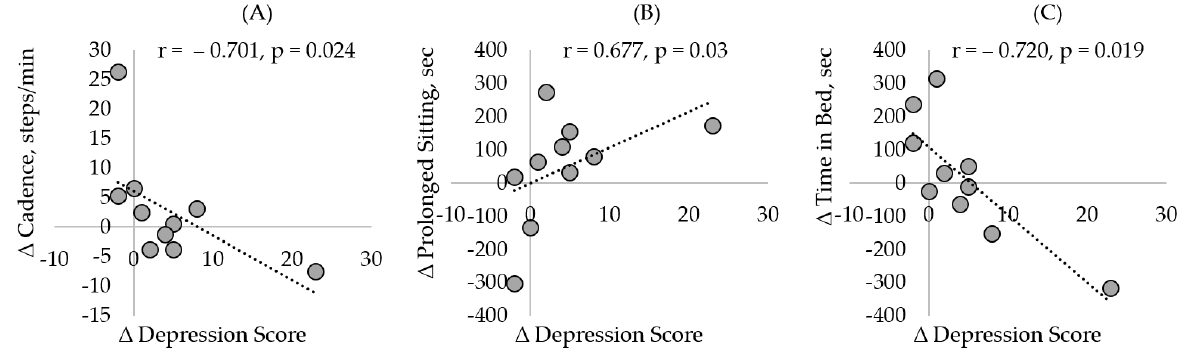
Figure 5. Association between change in depression and sensor derived parameters. Increase in depression symptoms was significantly correlated with ( A ) change in cadence, ( B ) change in prolonged sitting, and ( C ) change in time in bed. The symbol ∆ represents the change in metric (During‒Before pandemic). Table 3. Association with the change in depression measured using Spearman correlation analysis.